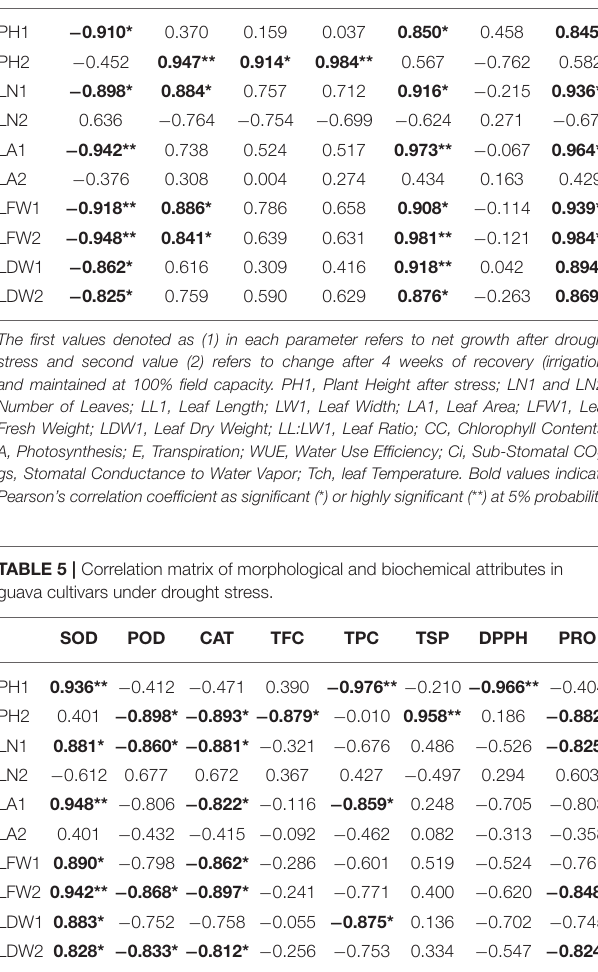
TABLE 4 | Correlation matrix of morphological and physiological attributes in guava cultivars under drought stress. Tch Ci E gs WUE